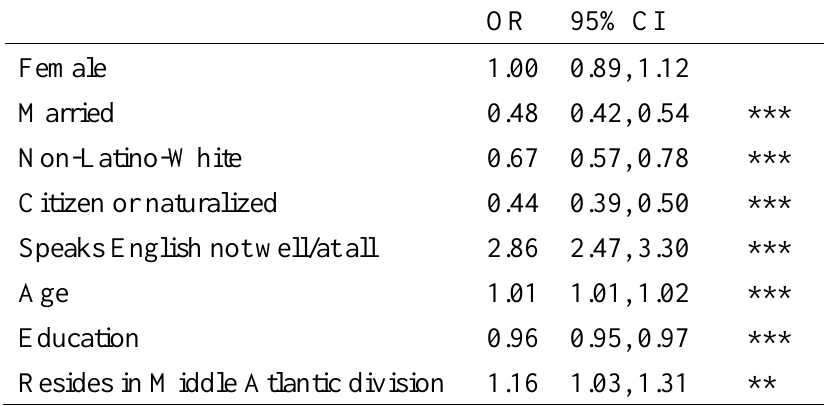
Table 3. Multivariable logistic regression predicting likelihood of being in